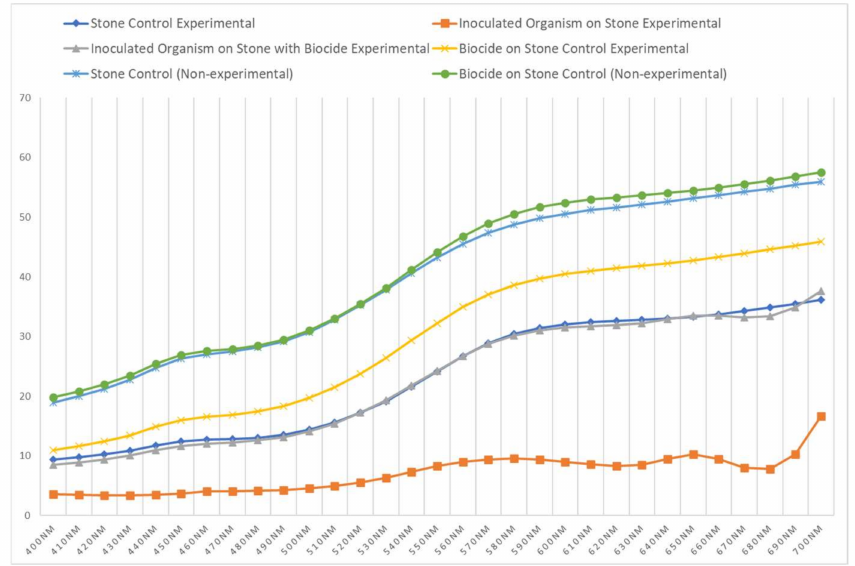
Figure 2. Color reflectance resulting from the biofilm development of P. sesnandensis on stone probes with and without carrageenan treatment. Non-experimental designations refer to control probes under dry environment (not subjected to the experimentally controlled humid